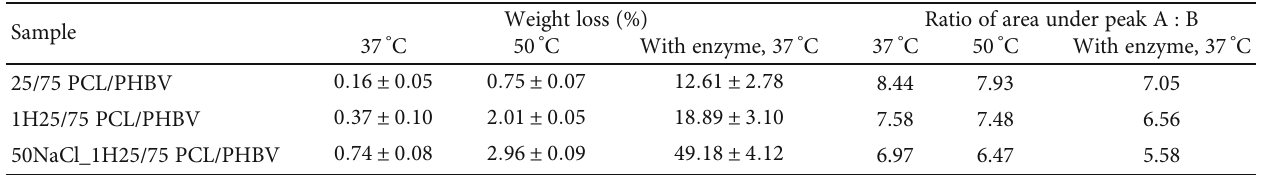
Table 7: Amounts of weight loss and ratios of area under peak A : B from IR spectra of pristine 25/75 PCL/PHBV sca ff old and 25/75 PCL/PHBV with surface modi fi cation and with local pores at 30 days of degradation under di ff erent conditions.